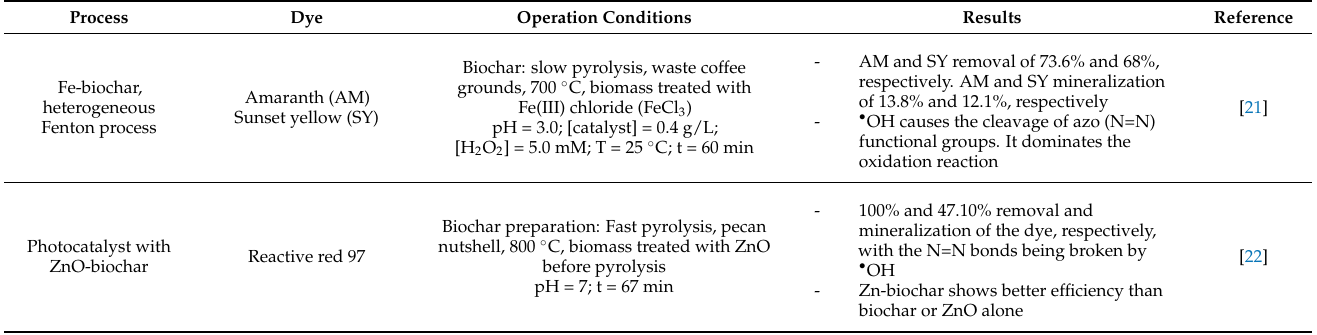
Table 3. Treatment of dyes by coupling biochar with advanced oxidation processes